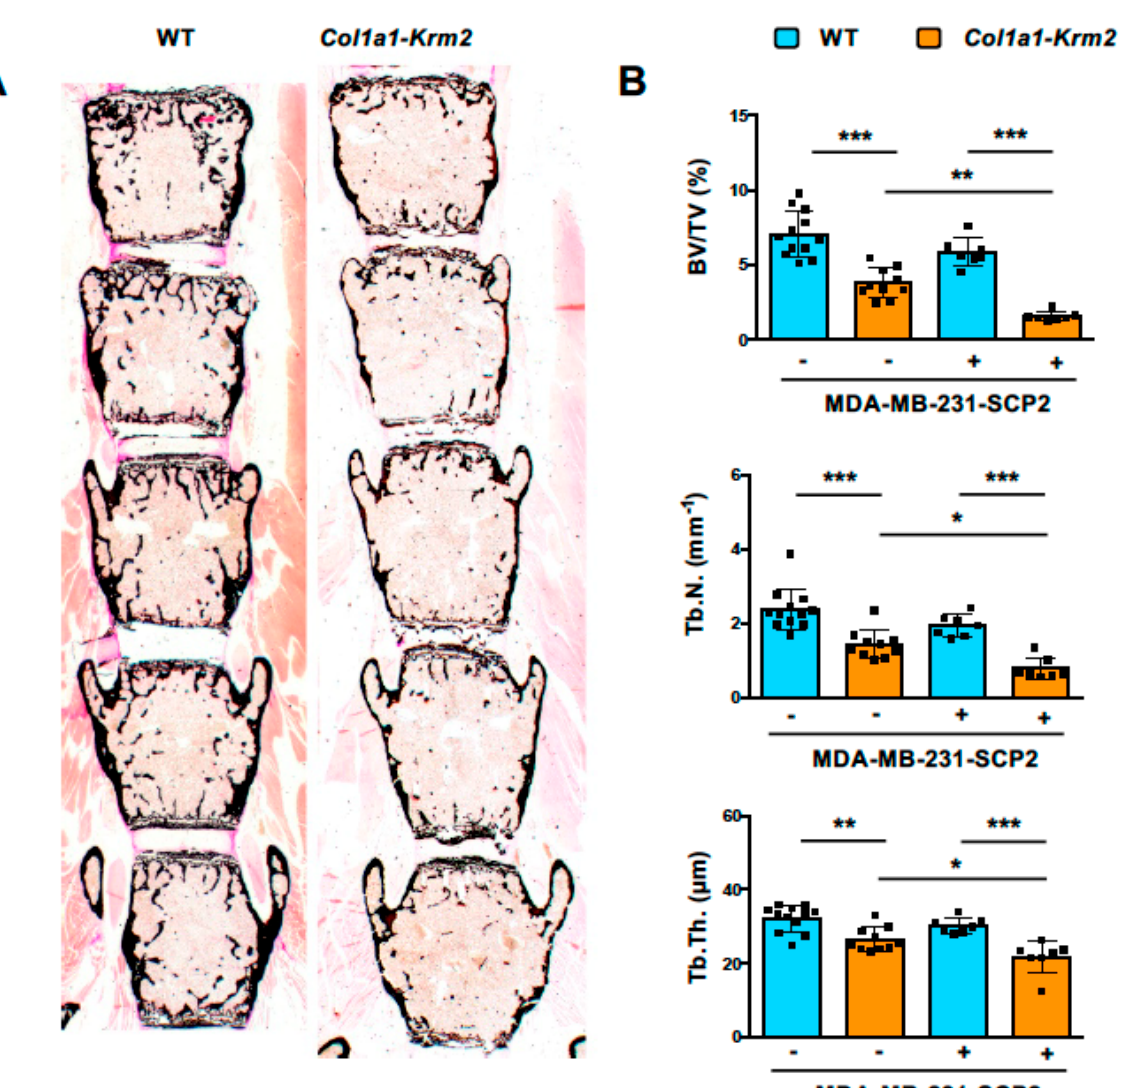
Figure 3. Col1a1-Krm2 -transgenic NSG mice display strongly reduced trabecular bone mass in the spine. ( A ) Representative von Kossa staining of undecalcified lumbar spine sections from NSG mice (WT) and Col1a1-Krm2 -transgenic NSG mice ( Col1a1-Krm2 ) three weeks after injection of MDA-MB- 231-SCP2 cells. Mineralized bone is stained in black. ( B ) Histomorphometric quantification of the trabecular bone volume per tissue volume (BV/TV), trabecular number (Tb.N.) and trabecular thick- ness (Tb.Th.) in the two groups of mice with (+) or without ( − ) injected cancer cells. Data represent mean ± standard deviation ( n ≥ 7). Statistical significance was determined by one-way ANOVA; * p < 0.05, ** p < 0.005, *** p < 0.0005.